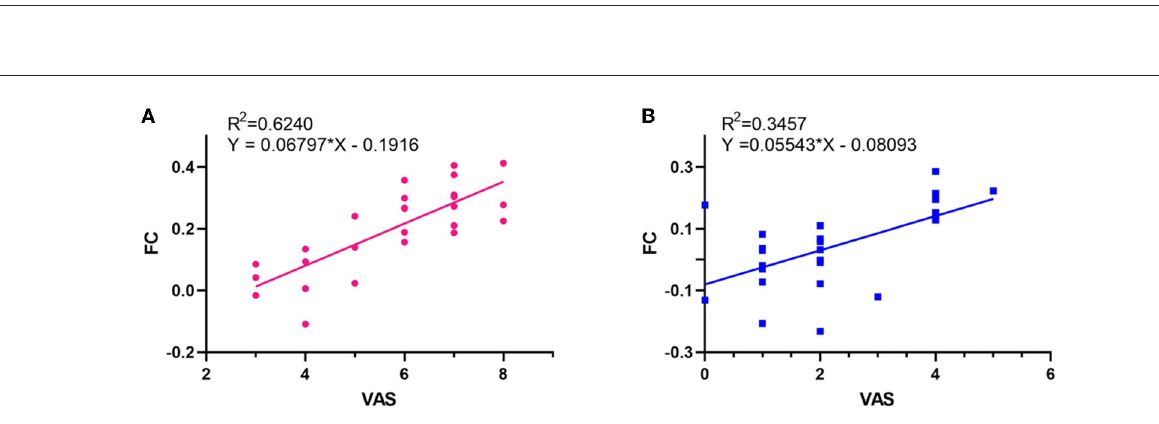
FIGURE7 Relationships between FC and VAS scores. (A) At pre-acupuncture. (B) At